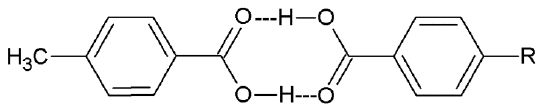
Figure 2. Intermolecular hydrogen bonds between two aromatic carboxylic acid molecules.